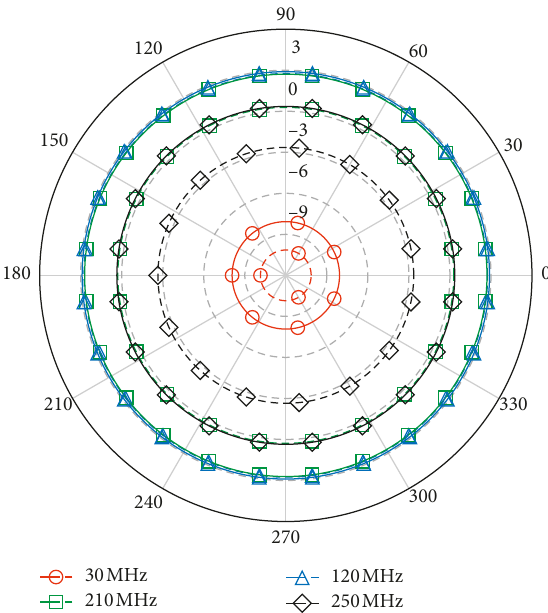
Figure 20: H-plane pattern (solid line for GOA; dashed line for IWO).